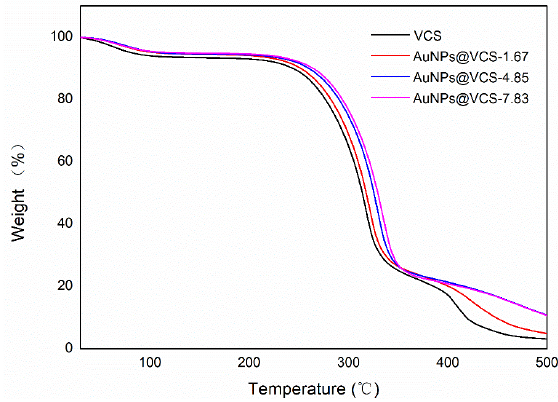
Figure 7. TG curves of VCS and AuNPs@VCS.